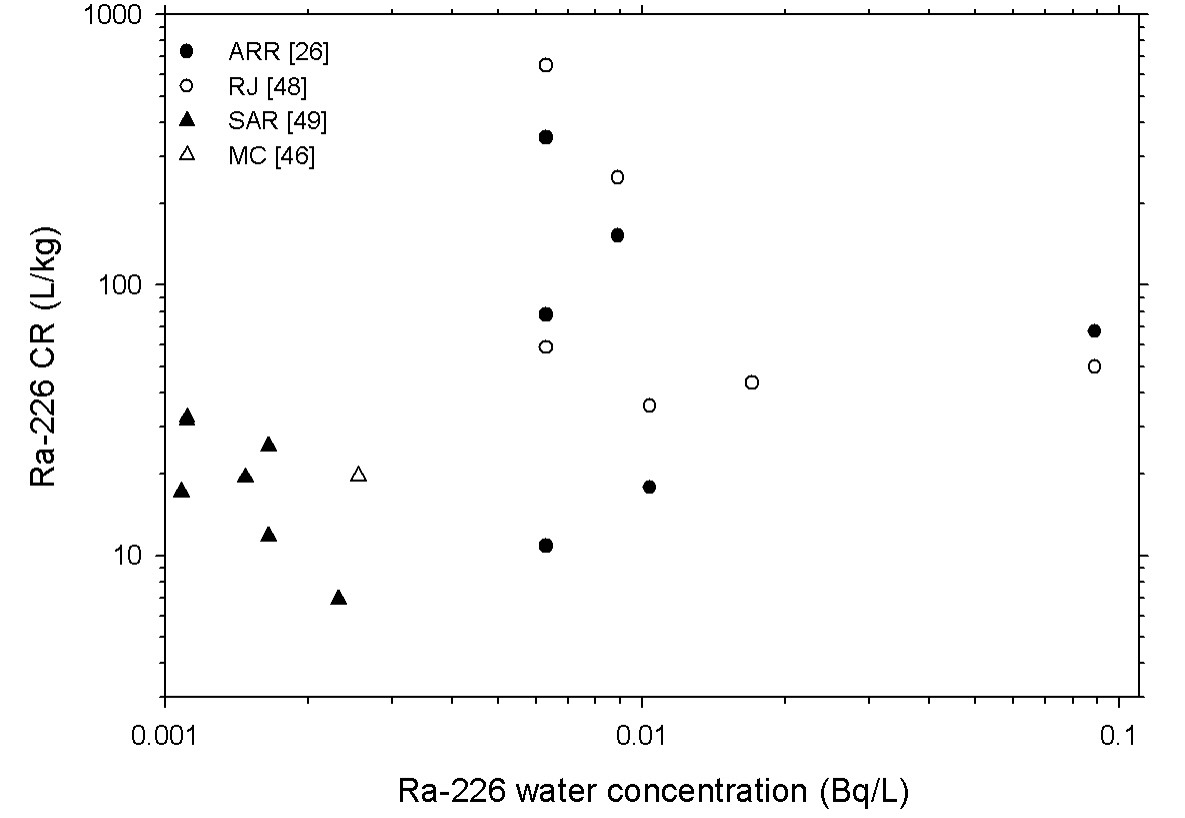
FIGURE 4. 226 Ra CRs vs. water concentrations for samples of barramundi ( Lates calcarifer ) from four studies. ARR = Alligator Rivers Region; RJ = Rum Jungle; SAR = South Alligator River; MC = Magela Creek.